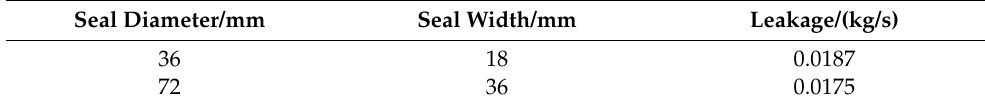
Table 2. The leakage with different seal diameter and width.